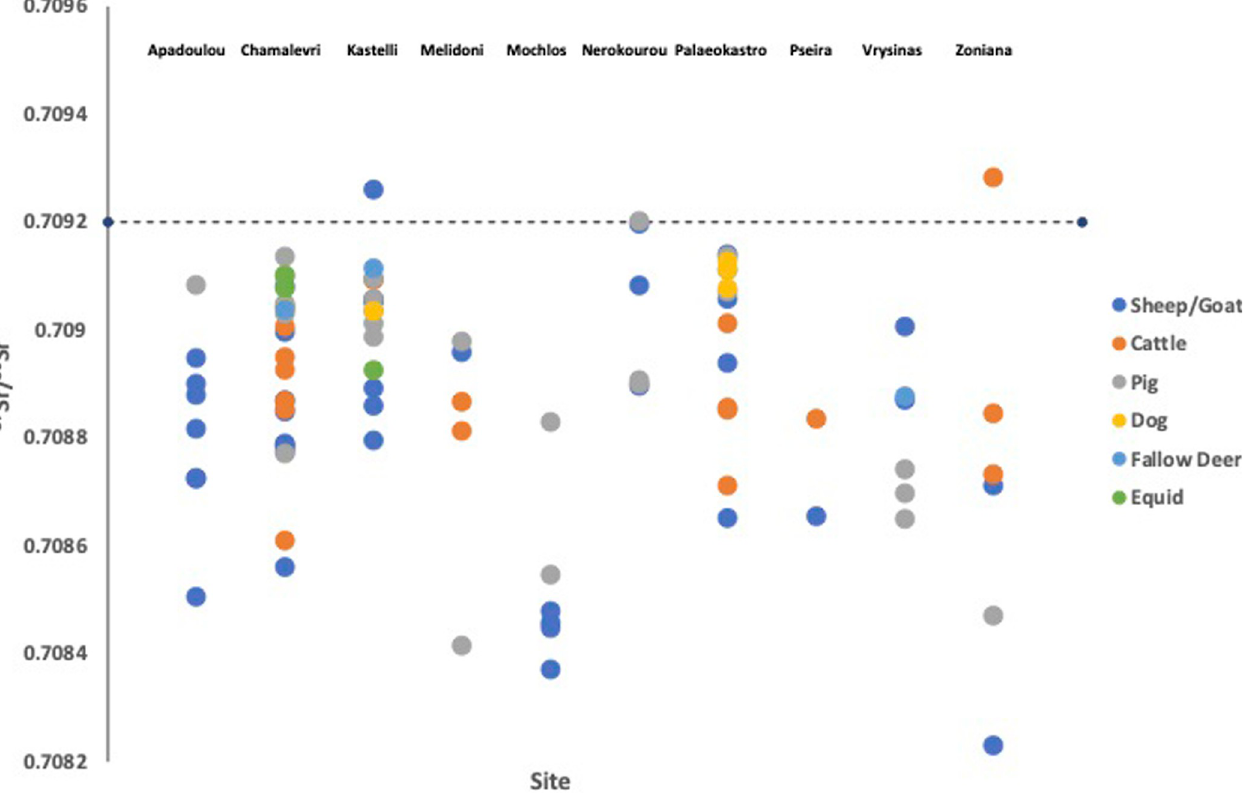
Fig 2. Strontium isotope values of faunal enamel samples from the archaeological study sites in Crete. Also shown is a line indicating the marine strontium isotope value of 0.7092.